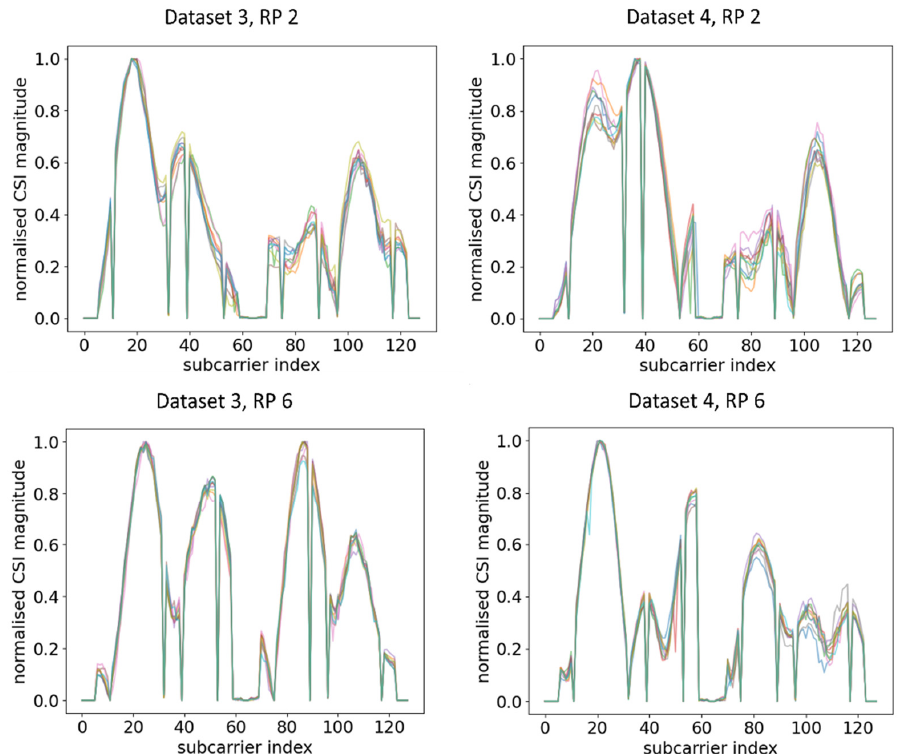
Figure 6. Plots of CSI amplitude in different orientations of RPi3B+ as compared with the ORI orientation in Figure 5 in the same time period at different RPs using AP